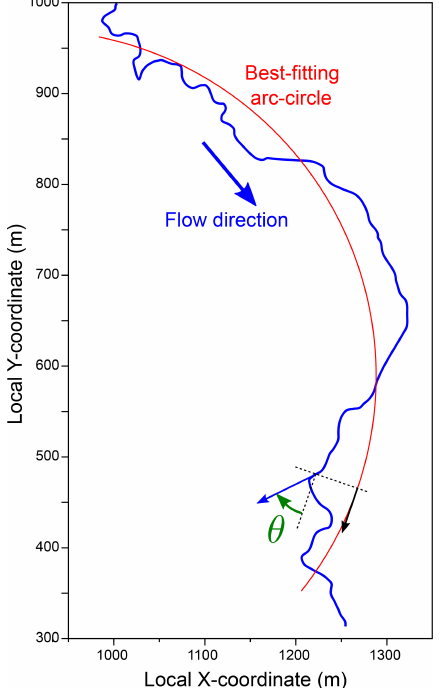
Figure 3. Definition of θ , the local angular deviation of the channel direction from a lower-frequency behavior. Here this low-frequency planform is defined as an arc-circle (illustration on the Olivet River reach). It is worth noting that θ is signed: at the location indicated in the figure, θ is negative.